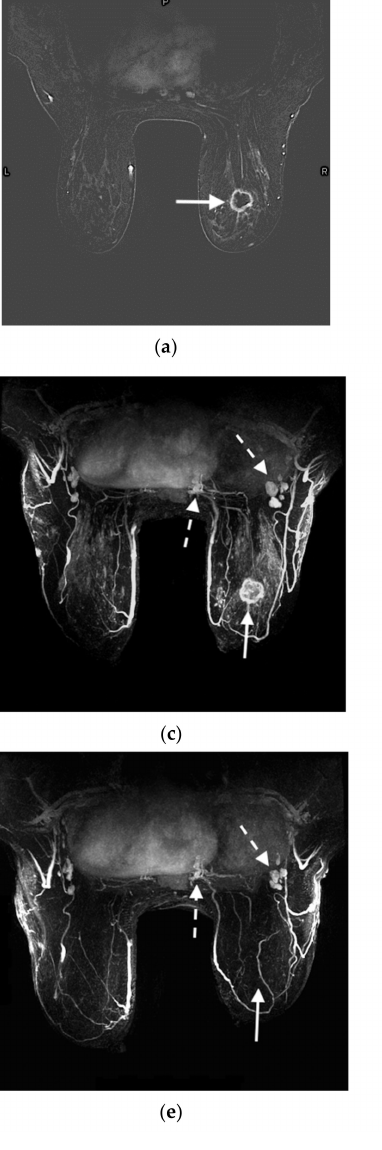
Figure 4. 47-year-old woman with a right breast invasive ductal carcinoma. ( a ) Prechemotherapy axial contrast-enhanced T1-weighted fat-suppressed MRI shows a 2.7 × 2.5 × 2.2 cm irregular mass with a thick rim of enhancement in the upper outer right breast (arrow), compatible with the known invasive ductal carcinoma. ( b ) Prechemotherapy axial contrast-enhanced T1-weighted fat-suppressed MRI shows an area of non-mass-like enhancement compatible with DCIS (edges demarcated by (*) located posterior to the mass (arrow). ( c ) Prechemotherapy maximum intensity projection image demonstrates a right breast mass (arrow) with associated enhancing right axillary and intramammary lymphadenopathy (dashed arrows), compatible with metastatic disease. ( d ) Postchemotherapy contrast-enhanced T1-weighted fat-suppressed MRI shows resolution of the right breast mass. Susceptibility artifact from the biopsy clip is seen in the tumor bed (arrow). The area of non-mass-like enhancement has also resolved (not shown). ( e ) Postchemotherapy maximum intensity projection image demonstrates resolution of the previously seen large right breast mass (solid arrow in tumor bed). The right axillary and intramammary lymph nodes are redemonstrated but have decreased in size (dashed